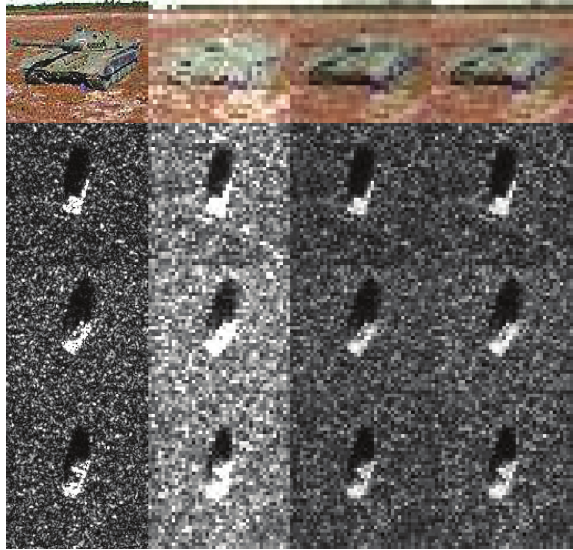
Figure 6: Results for different pooling.